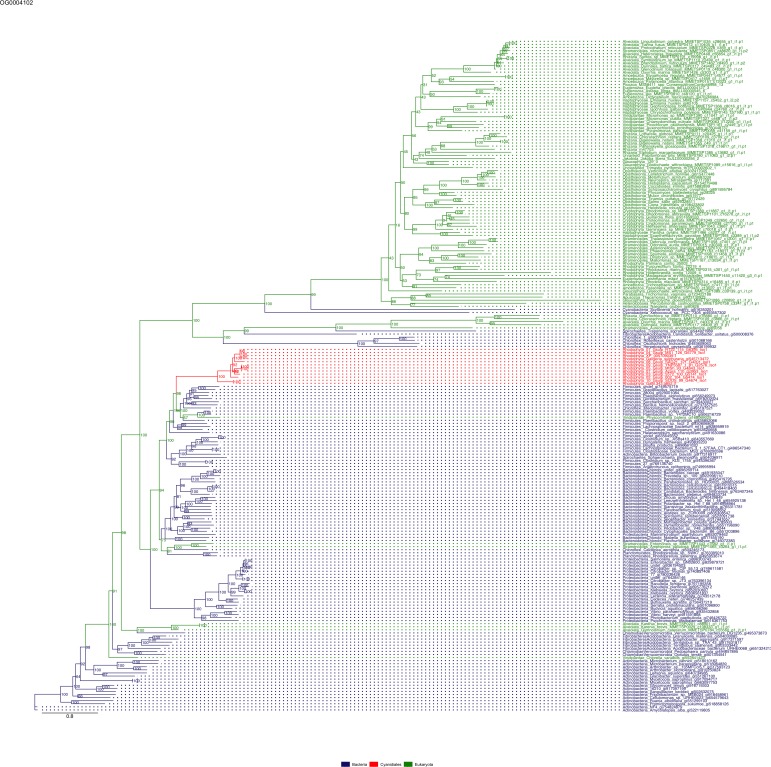
Sequence tree of orthogroup OG0004102.The tree is based on amino acid sequences. Archaea (yellow), Bacteria (blue), Cyanidiales (red), Eukaryotes including other red algae (green). Branches containing Cyanidiales sequences are highlited in red.